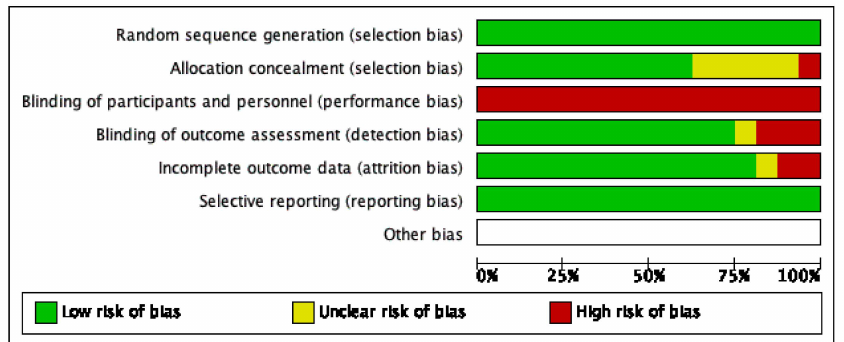
Figure 2. Summary of risk of bias assessment for each domain as a percentage of included studies.